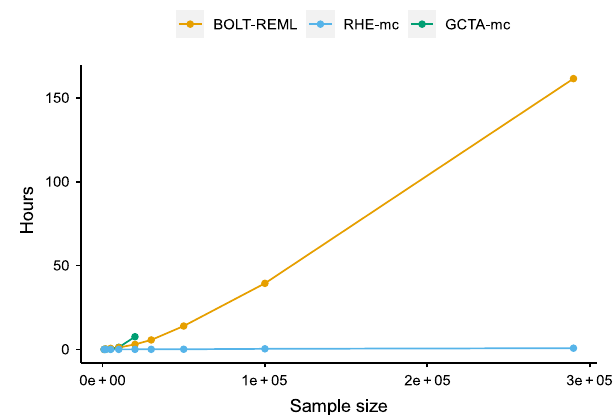
Fig. 3 Comparison of running time of RHE-mc, GCTA-mc, and BOLT- REML. We compared runtime of RHE-mc, GCTA-mc, and BOLT-REML with increasing sample size N (for a fi xed number of SNPs M = 459,792 and components K = 22).